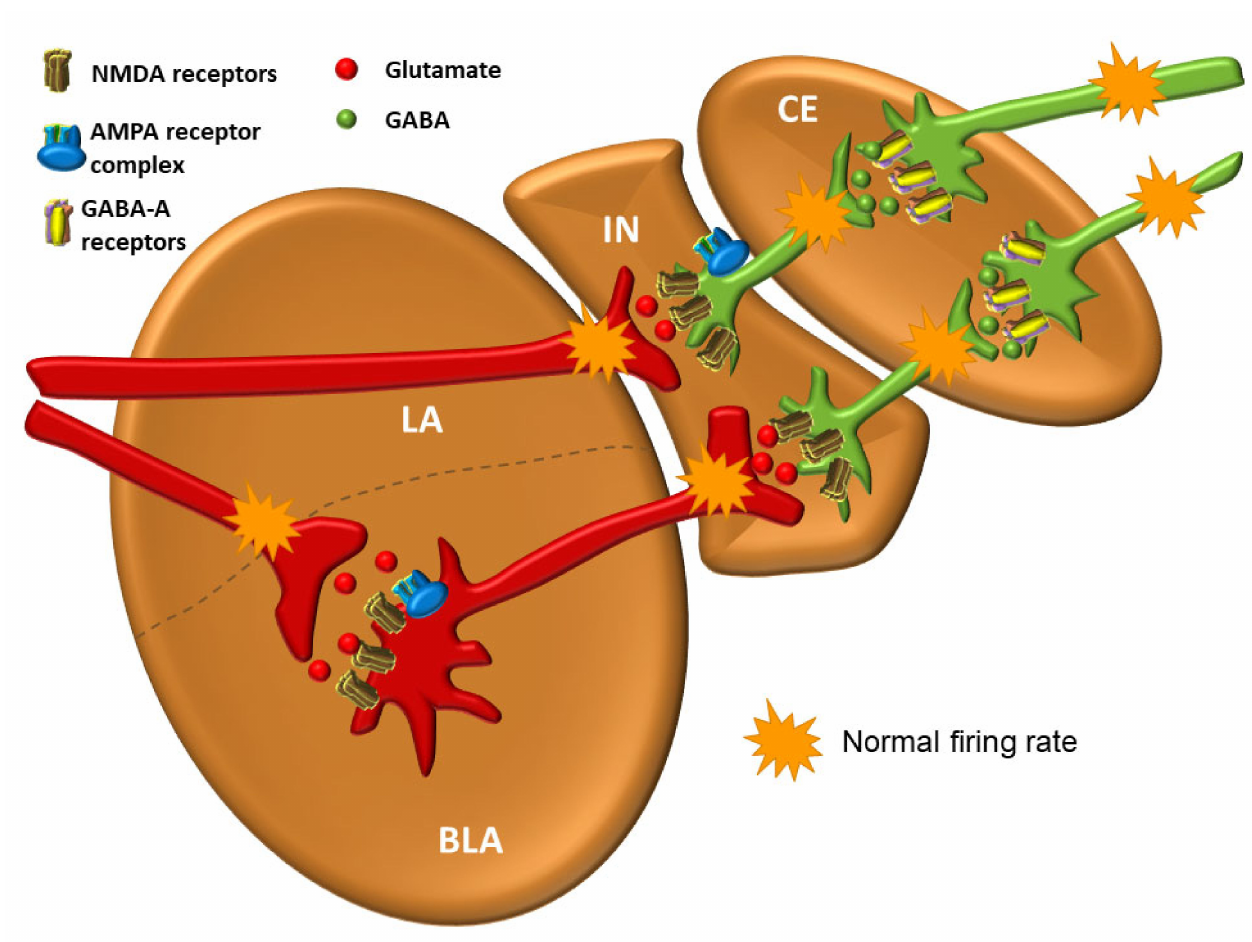
Figure 8. Balanced ratio of excitation and inhibition in amygdala in a healthy individual in a non-threatening situation. AMPA— α -amino-3-hydroxy-5-methyl-4-isoxazole propionic acid; BLA—basolateral nucleus of the amygdala; CE—central nucleus of the amygdala; GABA— γ -aminobutyric acid; IN—intercalated neurons; LA—lateral nucleus of amygdala; NMDA— N